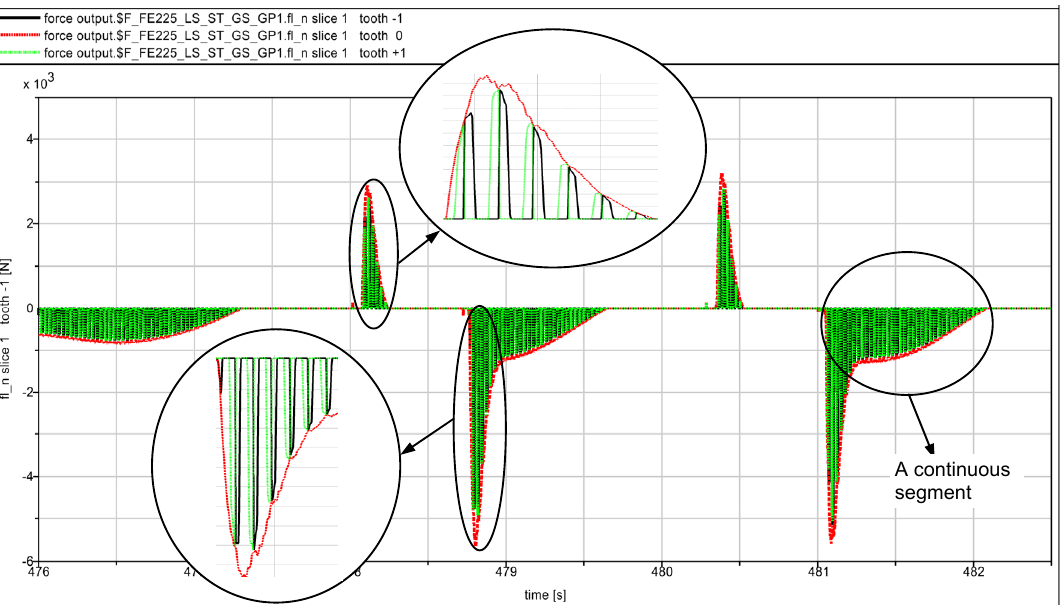
Figure 7. Time histories of gear contact force based on time domain simulation in SIMPACK ( U = 4 m/s). w